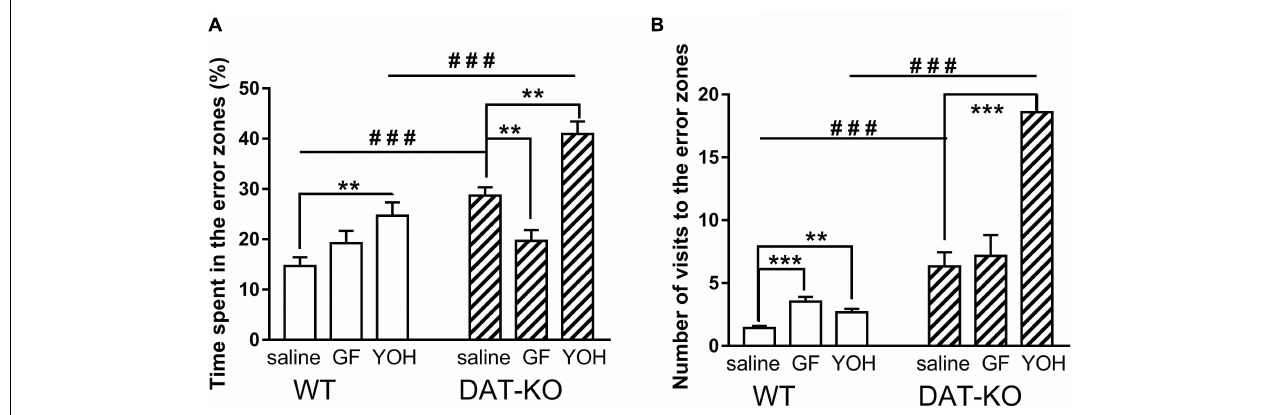
FIGURE 5 | Comparison of the time spent in the error zones of the maze (A) and number of visits to the error zones (B) of WT and DAT-KO rats; ### p < 0.001; one-way Kruskal–Wallis test combined with Dunn’s multiple-comparison post hoc test; ** p < 0.01; *** p < 0.001; Mann Whitney paired test; WT, wild-type; DAT-KO, dopamine transporter knockout